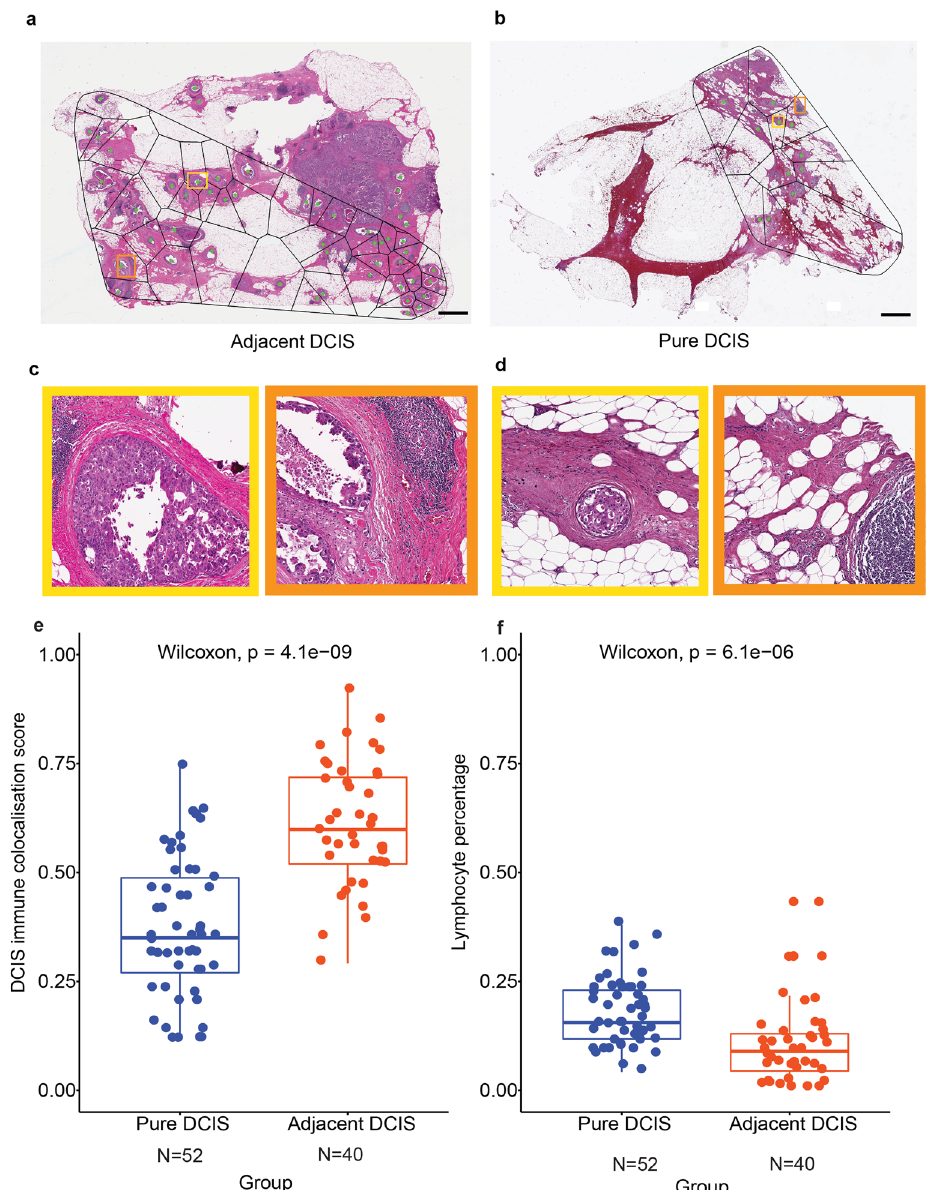
within the Voronoi of adjacent DCIS. d Representative DCIS region enclosed within the Voronoi of pure DCIS. e Boxplots illustrating the difference in DCIS immune colocalisation score calculated using the Morisita index. It was computed by associating individual DCIS duct with the surrounding lymphocytes within the Voronoi region; a high score indicates the spatial colocalisation of lymphocytes and DCIS ducts. Each point corresponds to a WSI image, 52 WSI from n = 40 patients in the pure DCIS and 40 WSI from n = 25 patients in the adjacent DCIS group. f Boxplots illustrating the difference in overall lymphocyte percentage in all cells for WSIs of pure DCIS and adjacent DCIS cases (after exclusion of invasive tumour regions), using only single-cell classi fi